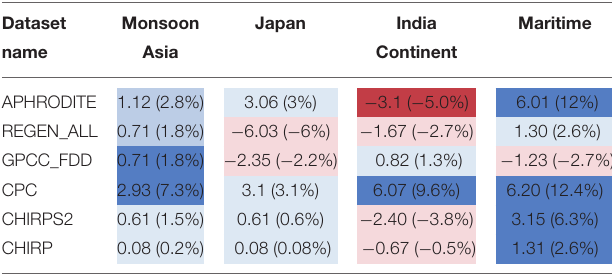
TABLE 4 | Trends per decade in the annual Rx1day (mm/decades and %/decade) for each product that has data covering the period of 1988–2013.